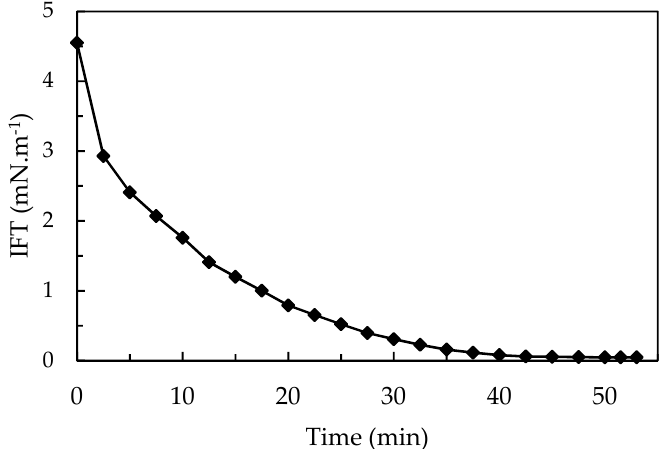
Figure 13. Interfacial tension (IFT) for the 12sulf20 SPSNP suspension (0.1 m / v %) and mineral oil as a function of time. Measurements were performed using Spinning Drop method.